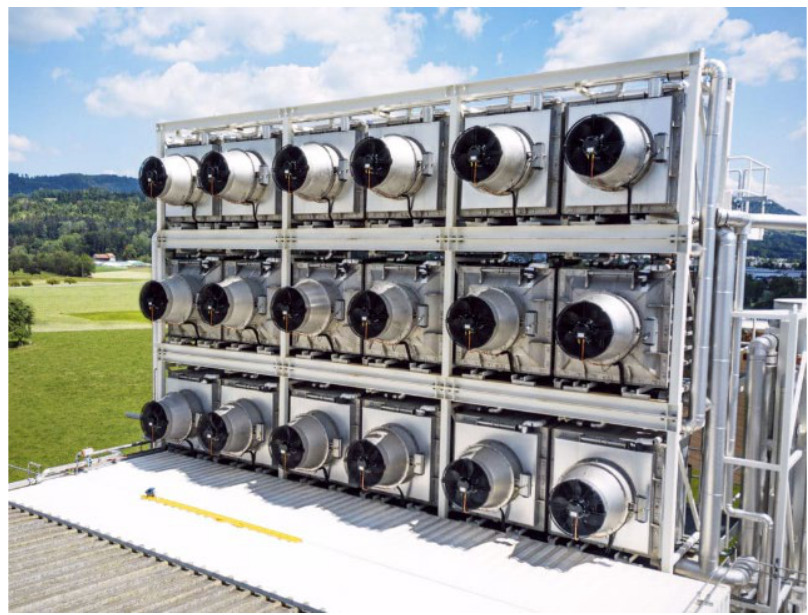
Figure 15. The Climeworks plant in Switzerland. Reproduced with permission granted by Climeworks AG [131] .